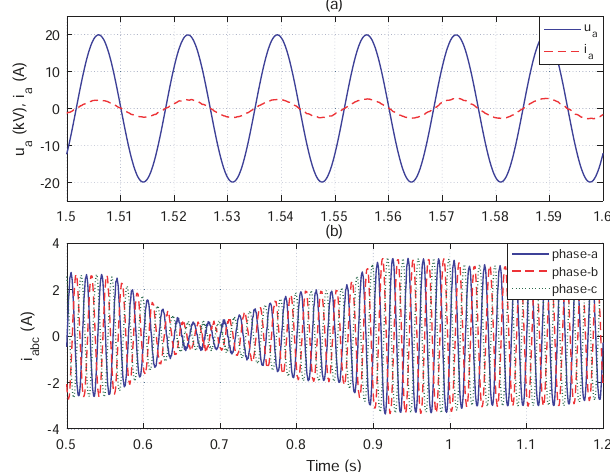
Figure 10. ( a ) Phase contrast between output voltage and current in PV system under DFA-SMB controller at t = 1.5–1.6 s. ( b ) Output three-phase current of PV system under DFA-SMB controller at t = 0.5–1.2 s.